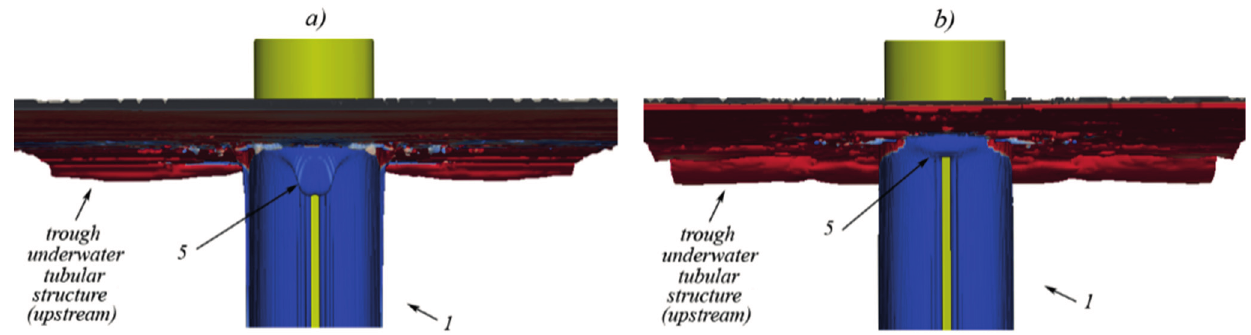
Figure 21. Close-up at the cylinder surface of viscous-flow structures as obtained from